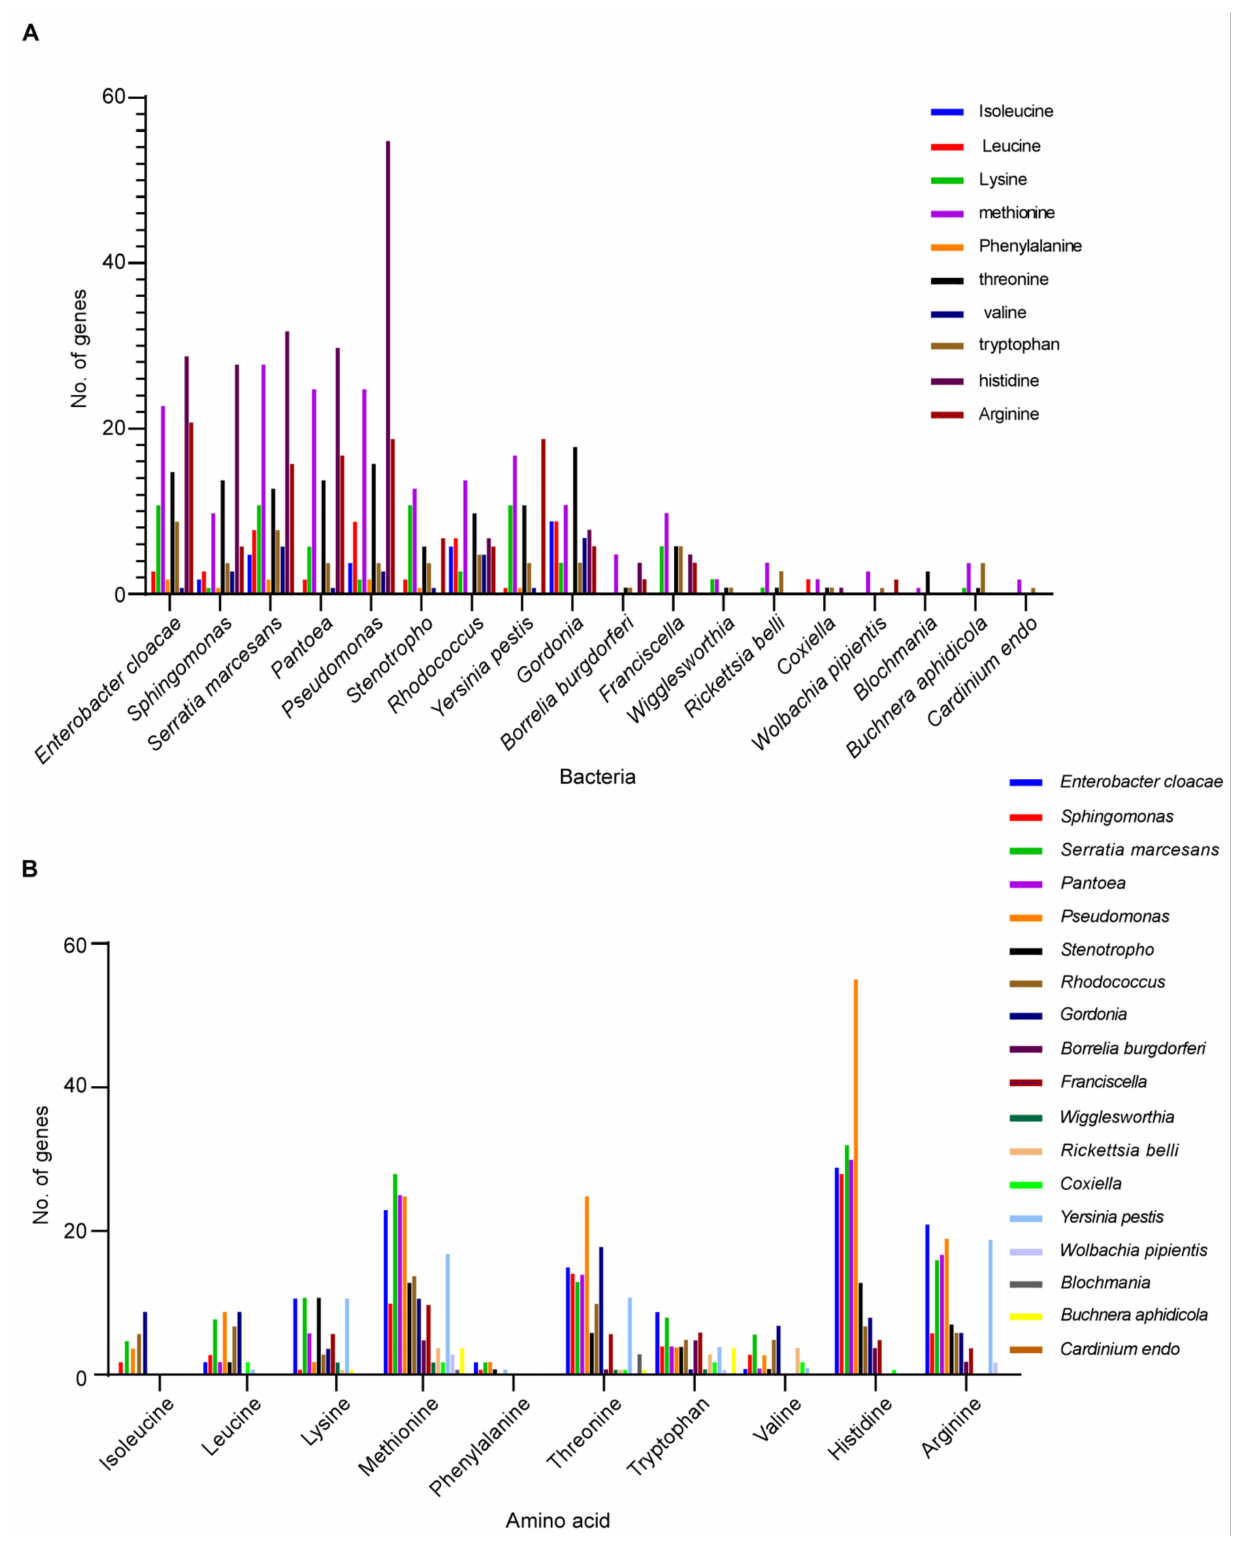
Figure 7. Graphs showing comparison of abundance of genes coding for ten essential amino acids expressed by symbiotic bacteria in blood-feeding insects and ticks versus symbiotic bacteria in plant-feeding insects. ( A ) Bacteria species along the axis versus abundance of genes for the different amino acids on the ordinate. ( B ) Amino acids along the axis versus number of genes forming the